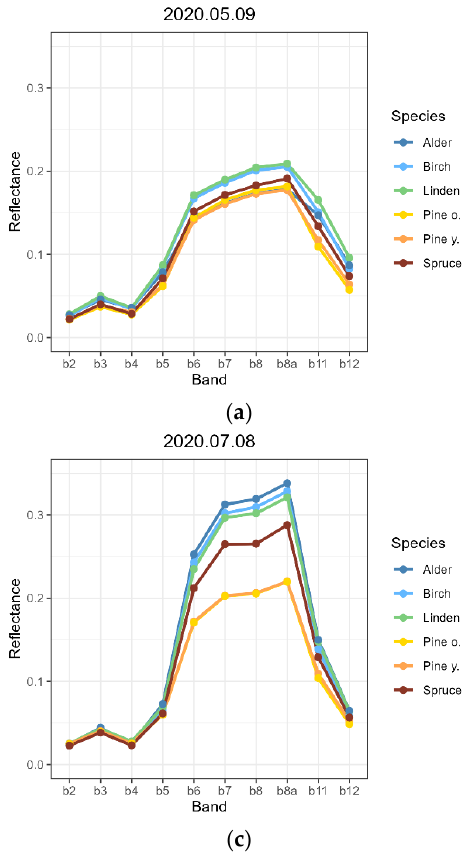
( f ) Figure 4. Spectral signatures of tree species for different phenological dates: ( a ) 9 May 2020; ( b ) 21 June 2020; ( c ) 8 July 2020; ( d ) 5 August 2020; ( e ) 24 September 2020; ( f ) 29 October 2020.